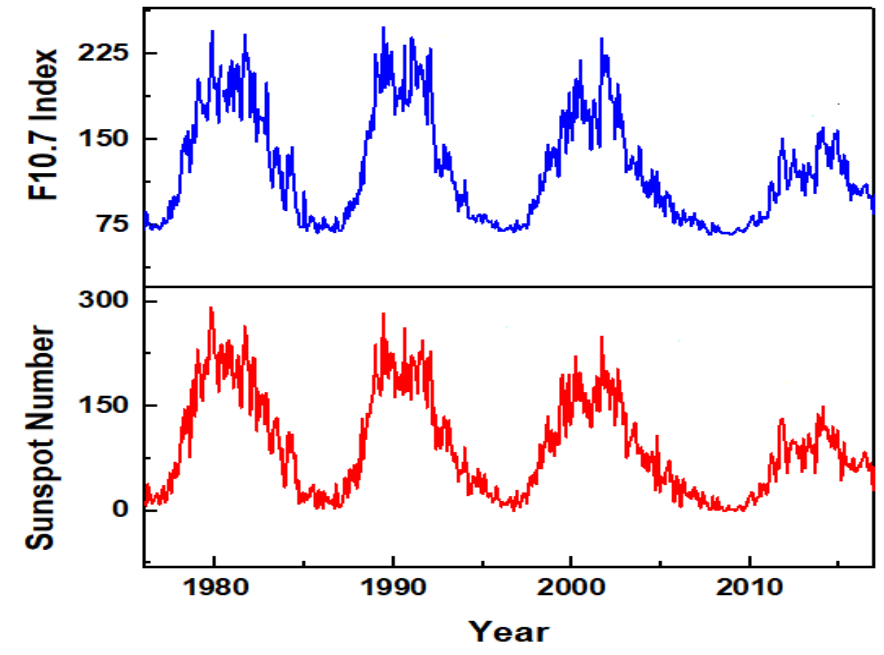
Figure 1. Variation of 10.7 flux and sunspot number for last three solar cycles [15].